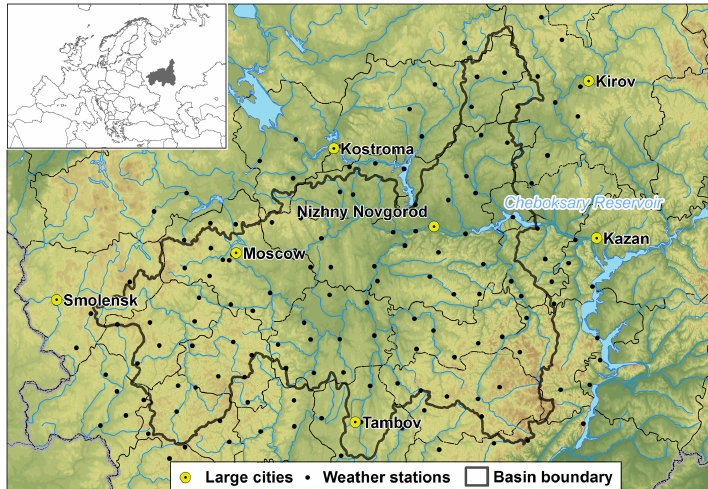
Figure 1. Cheboksary Reservoir basin: topography, river network and weather